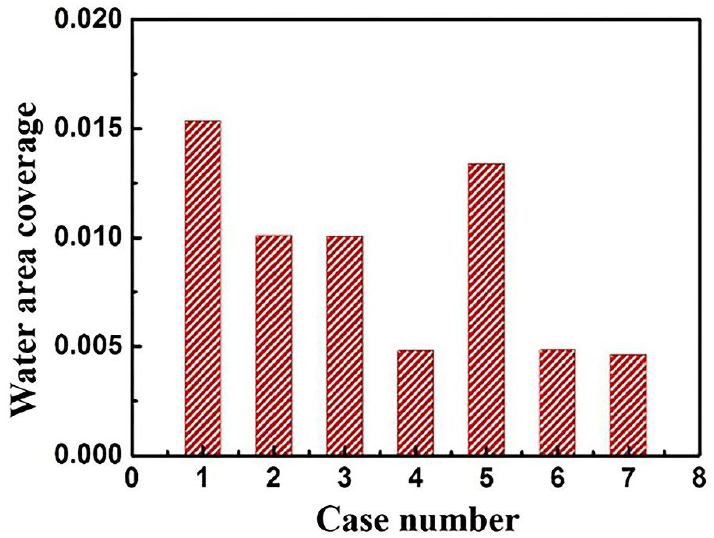
Figure 6. Effect of the pore shape on the averaged liquid water coverage on the gas diffusion layer (GDL) surface.